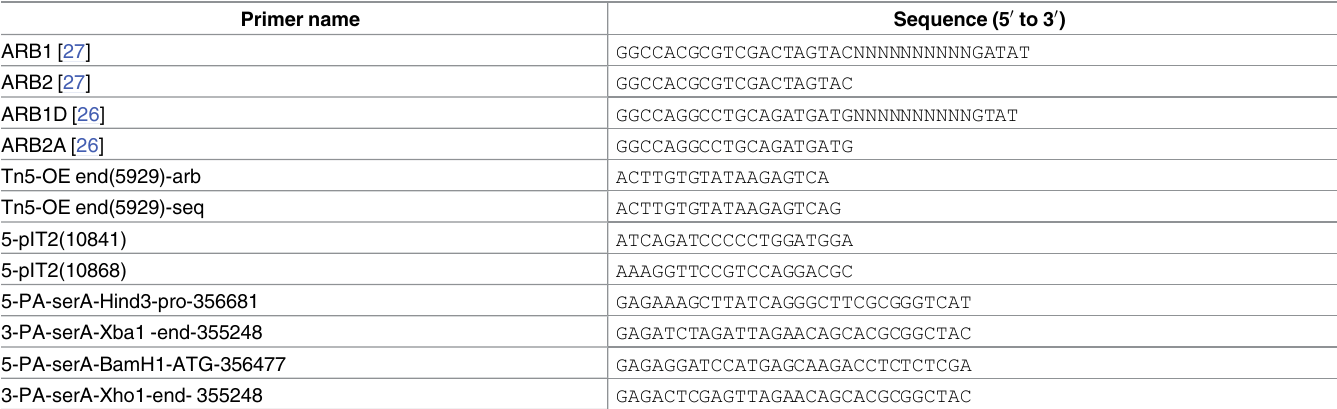
Table 1. PCR primers used in this study.